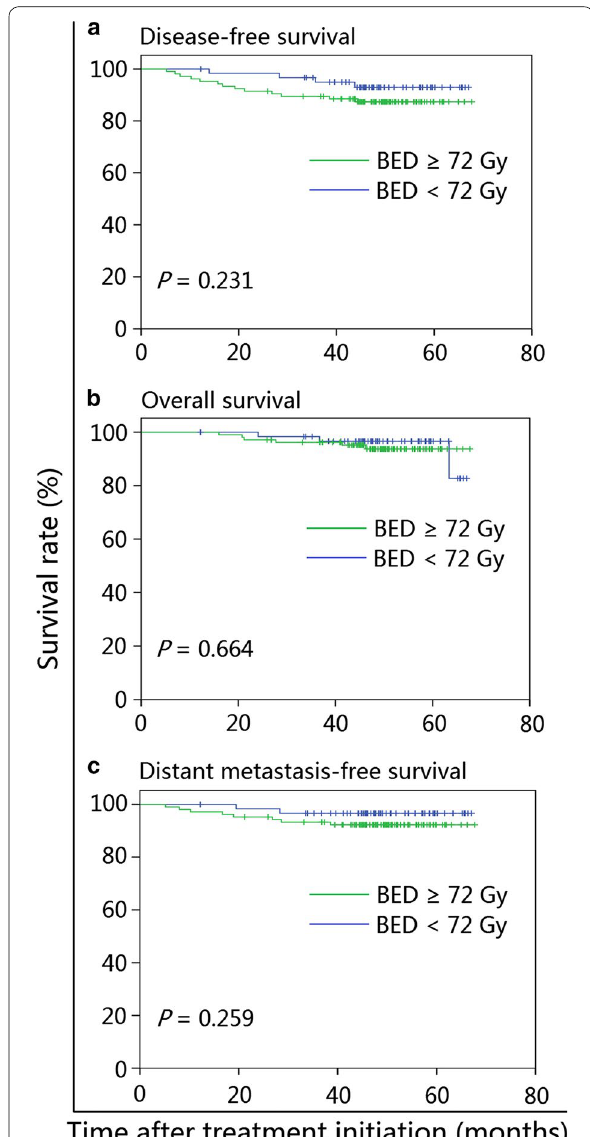
Fig. 4 Kaplan–Meier curves for prognostication by ENLN stratified by a BED < or 72 Gy: ( a ) disease‑free survival; ( b ) overall ≥ survival; ( c ) distant metastasis‑free